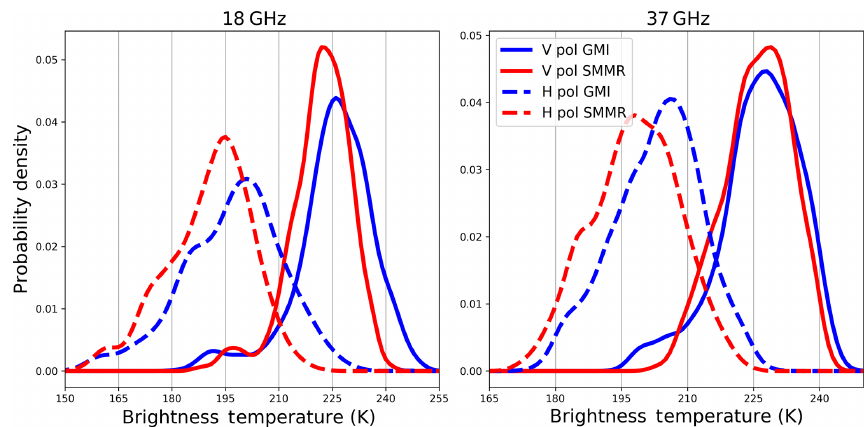
Figure 2. Probability density functions of July/August brightness temperatures over Antarctica for GMI in 2015 and SMMR in 1987.